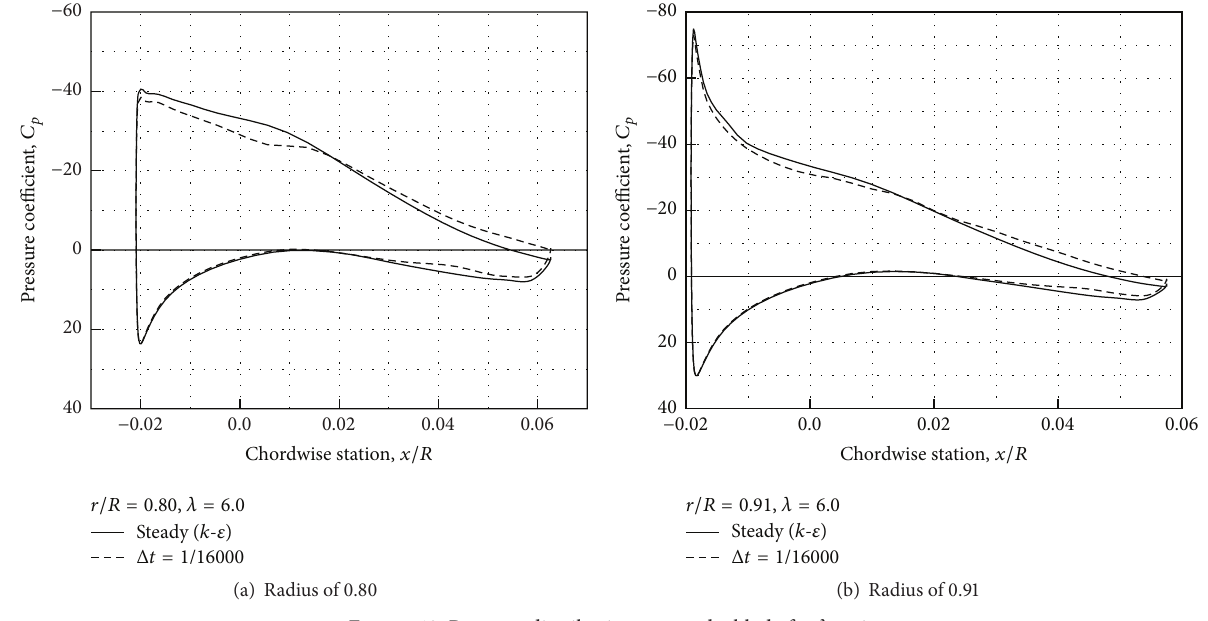
Figure 18: Pressure distributions around a blade for 𝜆 = 6 .